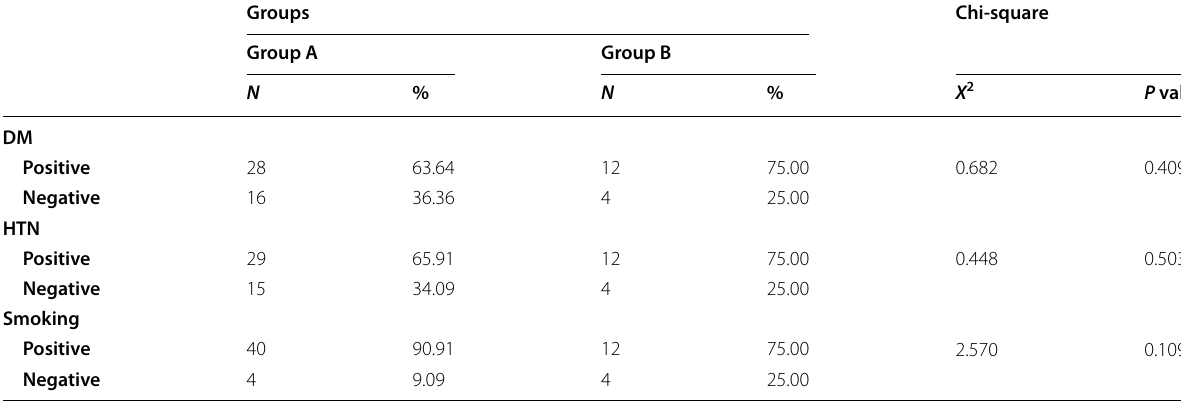
Table 2 CAD risk factors distribution in group A versus group